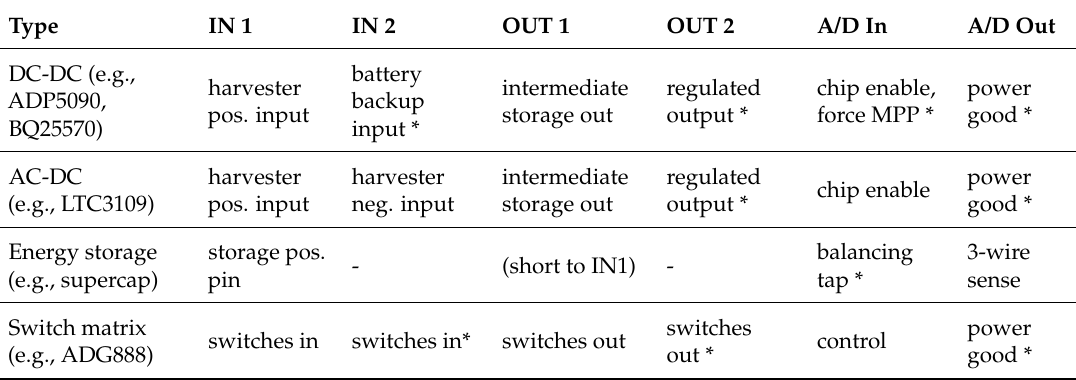
Table 2. Analysis of the pin assignments of commercially available power management components regarding power signals (IN/OUT) and control signals (A/D). A star indicates that a function is not available on every component.